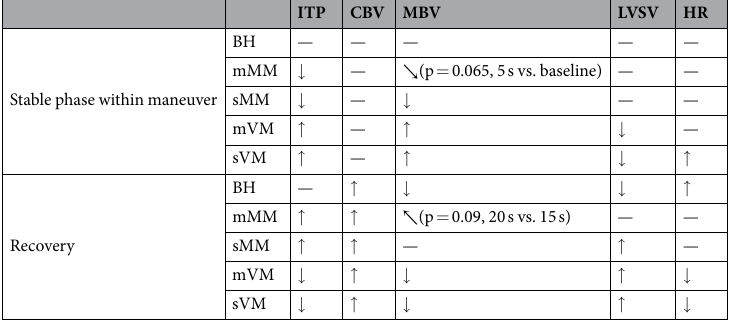
Stable phase within maneuver — — — — — — ↑ ↑ — — — ↑ ↑ — ↑ — Recovery ↑ ↓ ↑ ↓ ↓ ↑ ↓ ↑ ↓ Table 1. The summary of ITP, CBV, MBV, LVSV and HR changes within the strains and recovery